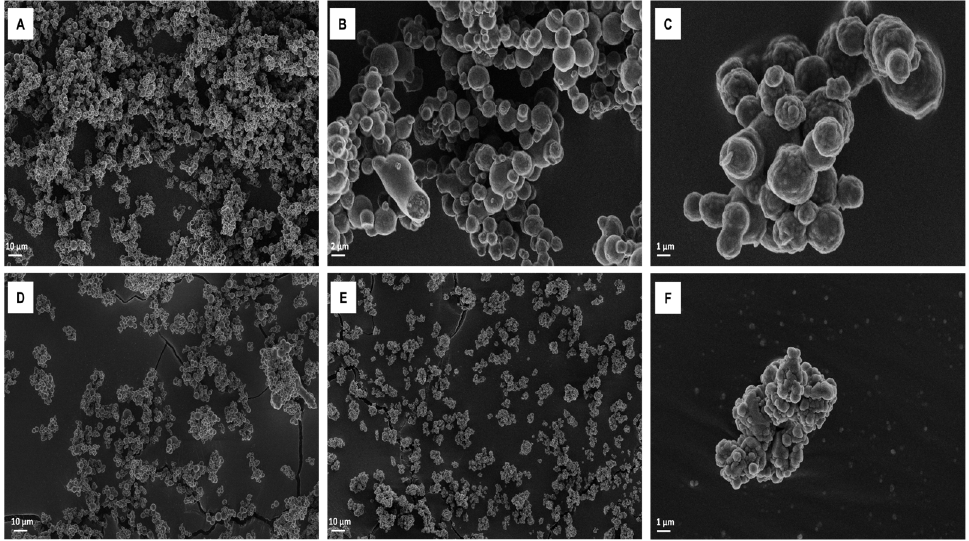
Figure 4. Scanning electron microscopy at different magnifications of ( A )TA-NC at 500×, ( B ) TA-NC at 3000× and ( C ) TA-NC at 10,000×, ( D ) PM at 500×, ( E ) mTA at 1000× and ( F ) mTA at 10,000×.